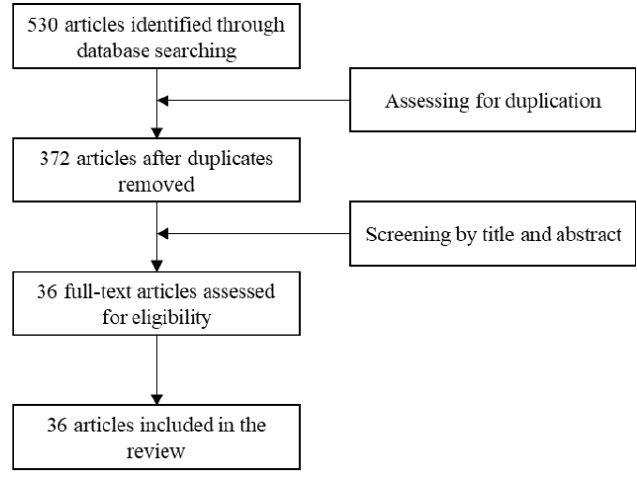
Figure 1. Article selection